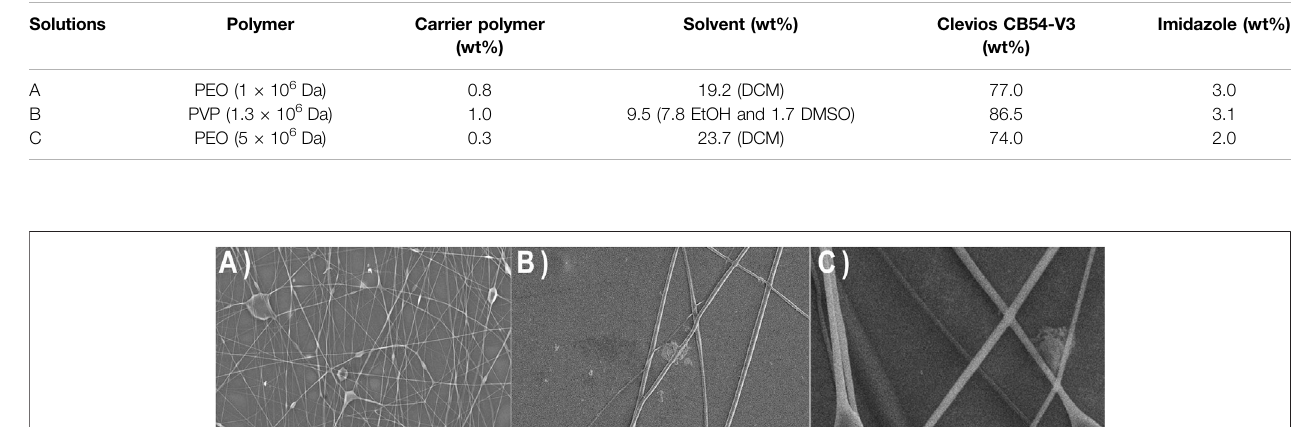
Frontiers in Physics |